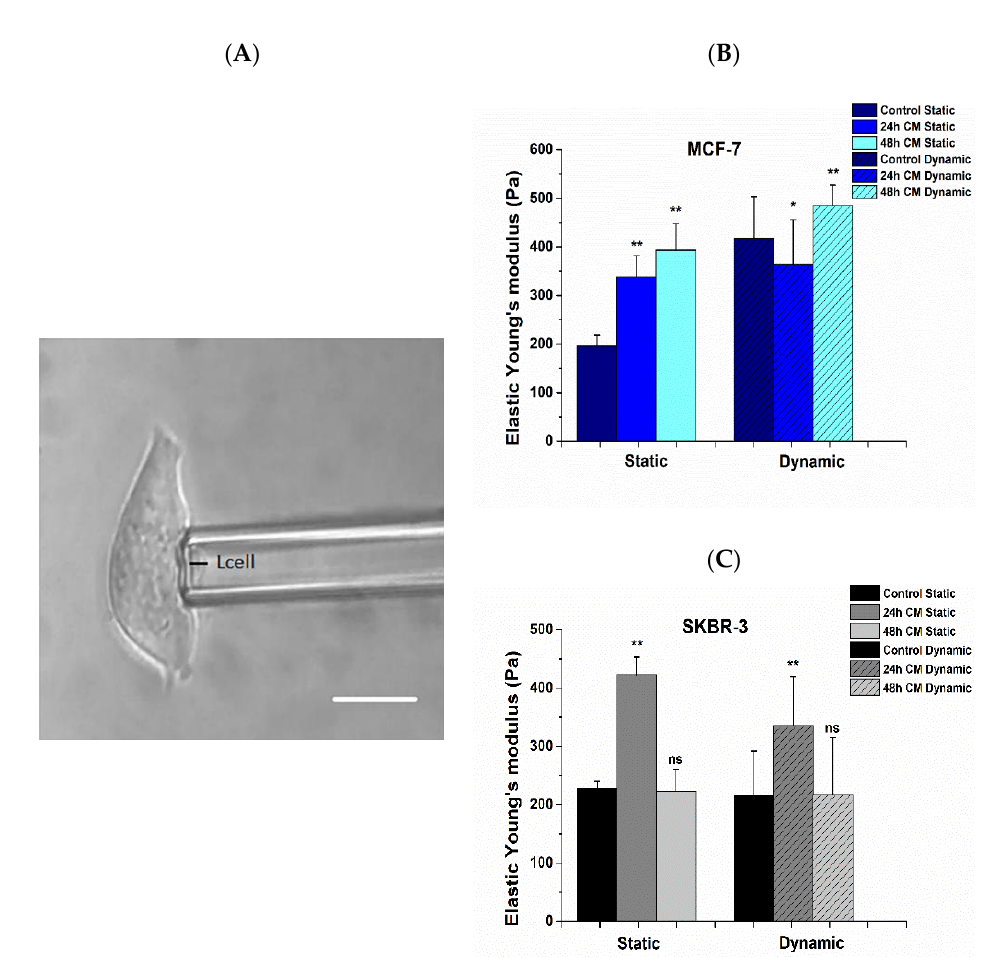
Figure 6. ( A ) Representative image of MCF-7 aspirated cell during micropipette aspiration technique. The cell length (black line) prolongation was recorded under a range of suction pressure (white color scale bar 10 µ m, × 20 microscope lens). The Elastic Young’s modulus of adhered cells prior to and post treatment with hUMSCs-CM for a range of applied pressure, 0.05 ÷ 340 Pa was determined via Equation (2). ( B ) the increased elastic modulus post treatment in both 24 h and 48 h of static culture and 48 h in dynamic culture indicates a stiff cancer cell with a confined potential for cell motility for MCF-7 cancer cells. In the case of SKBR-3 cells, ( C ) the elastic modulus increases after 24 h of treatment and decreases after 48 h of treatment in both static and dynamic conditions revealing the remaining aggressiveness of this cancer phenotype. Data represents mean values ± SD of three independent experiments, ns p > 0.05, * p < 0.05 and ** p <